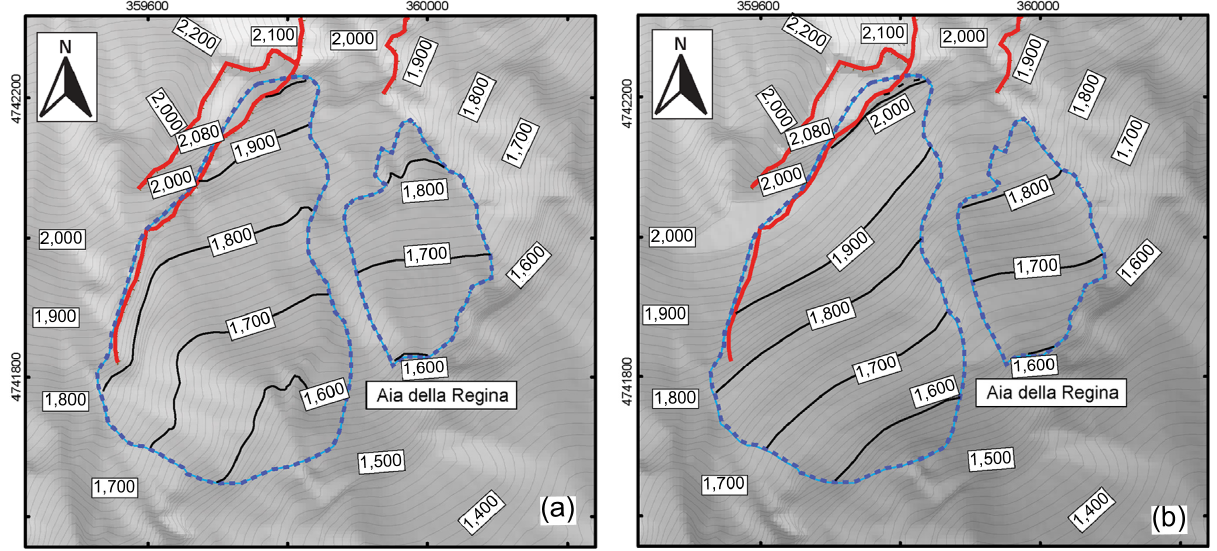
Figure 15. Aia della Regina source areas: 2D reconstruction of present ‐ day ( a ) and pre ‐ failure topography ( b ). Dashed, blue lines envelop detachment areas; the present escarpment is also traced. The projected coordinate system is UTM33N ‐ WGS84.